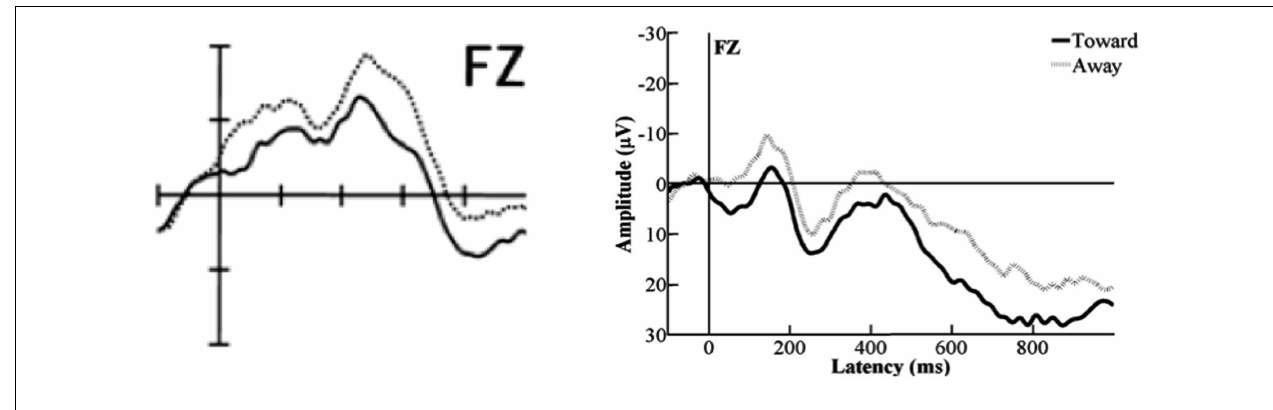
FIGURE 8 |A comparison between the ERPs deducted from the data published in Hoehl et al., 2008, p. 13; Figure 2; sample electrode depicted on the left) and those deducted from our data (sample